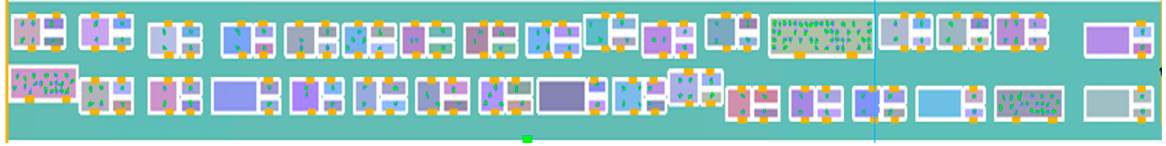
Figure 3. Partial view of evacuation model.